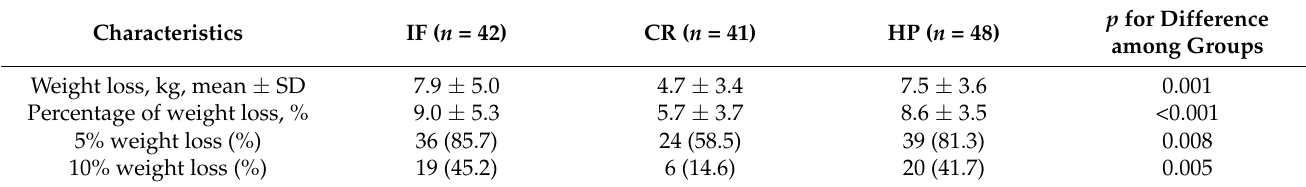
Table 2. Participant characteristics after 12 weeks of weight loss intervention.